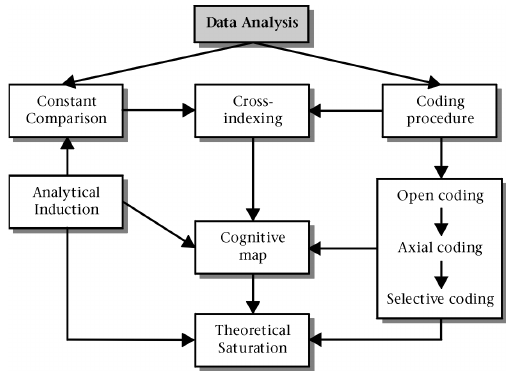
Figure 3: A map of data analysis methods and techniques